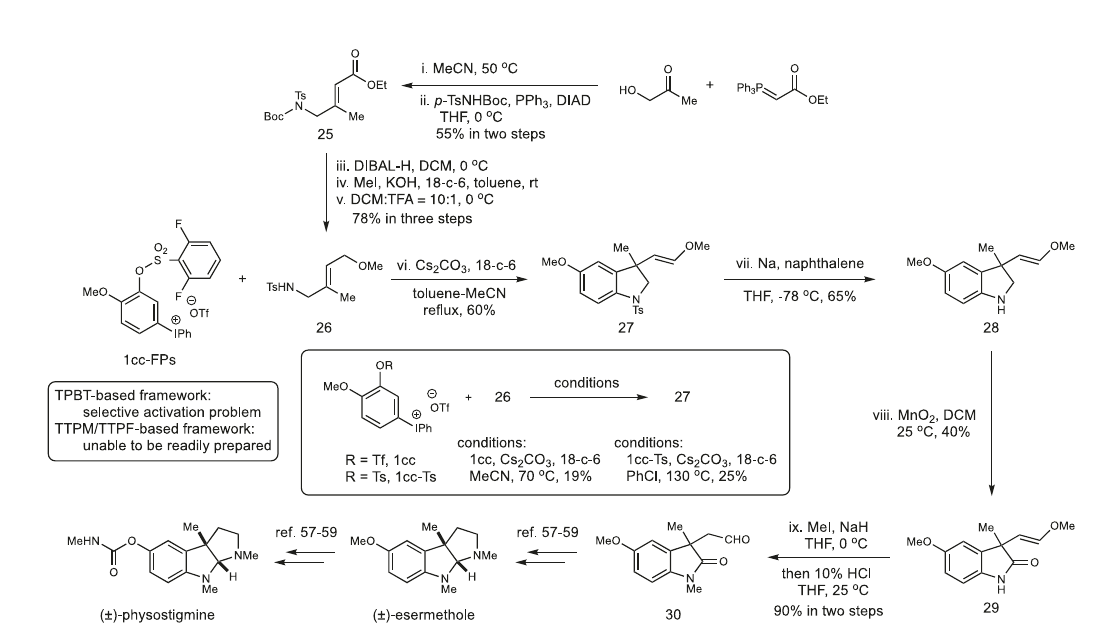
Fig.8|Studytowardthesynthesisof(±)-esermetholeand(±)-physostigmine. A preparation of compound 30 was realized by employing domino aryne nucleophilic-ene reaction between aryne precursor 1cc-FPs and compound 26 as